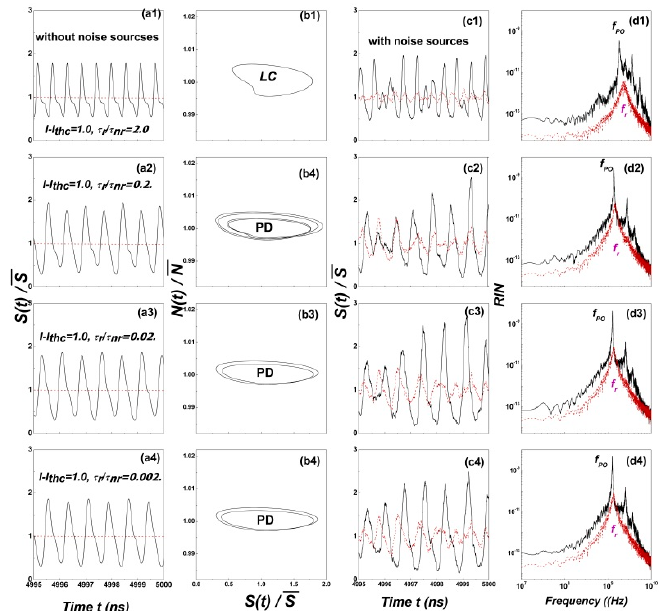
Figure 5. Time, phase portraits, and RIN of photon number S ( t )/ S of an SL at route to chaos point, when ( I - I thc ) = 1 m A and τ r / τ nr = 2.0, 0.2, 0.02, and 0.002.